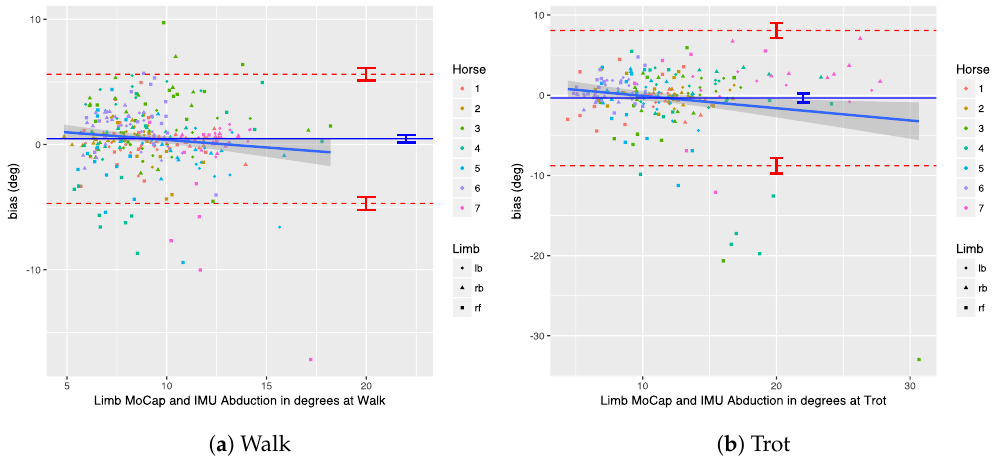
Figure 21. Bland–Altman analysis for abduction angles at walk and